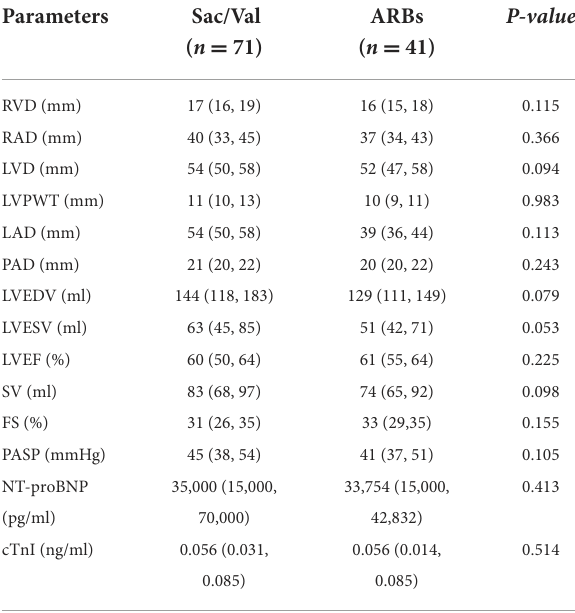
TABLE 3 Echocardiographic parameters and cardiac biomarkers at baseline and follow-up in two groups.